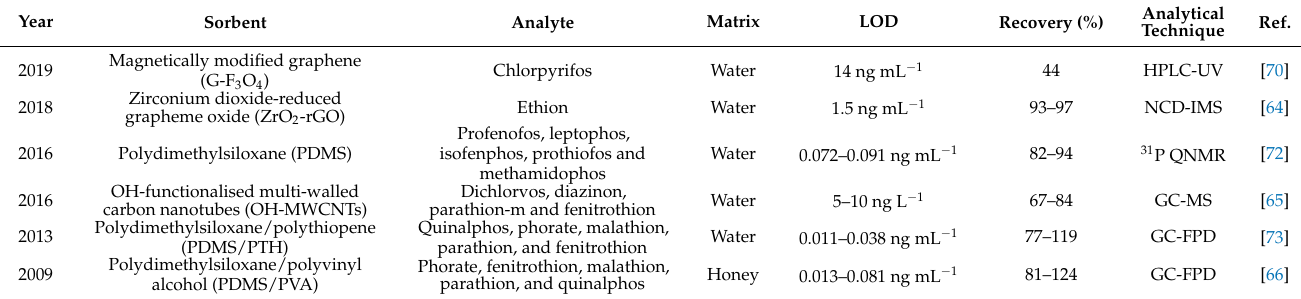
Table 5. Summary of past studies on the application of SBSE as a sample preparation technique for OPPs’ determinations. Sorbent Analyte Recovery (%) Analytical Technique